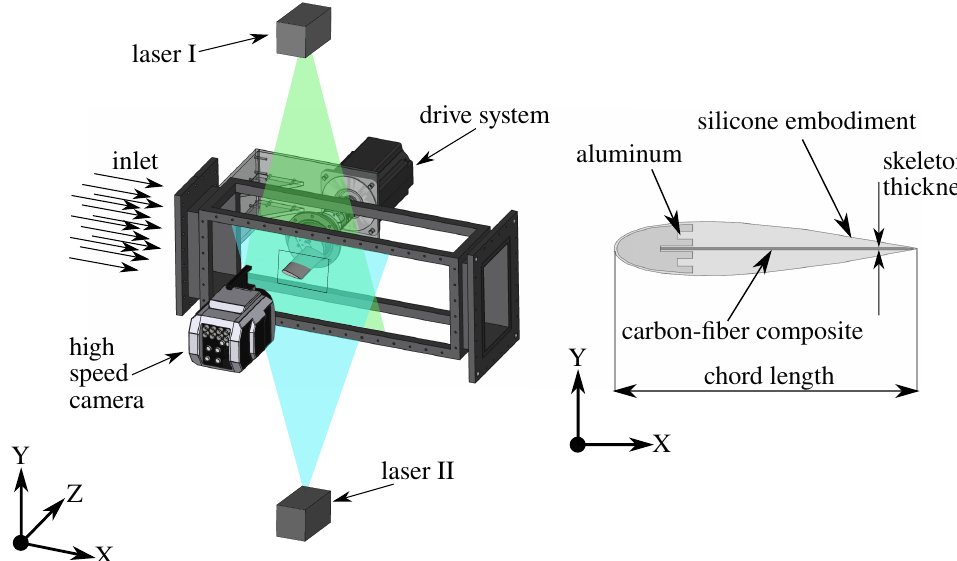
Figure 3. Experimental setup: ( Left ) The water tunnel test section is equipped with a servo-drive system allowing for a precise set-point control. A six-axis load cell captures the forces and moments acting on the profile. ( Right ) The stiffness of the flexible hydrofoils can be adjusted by the thickness of the carbon-fiber composite